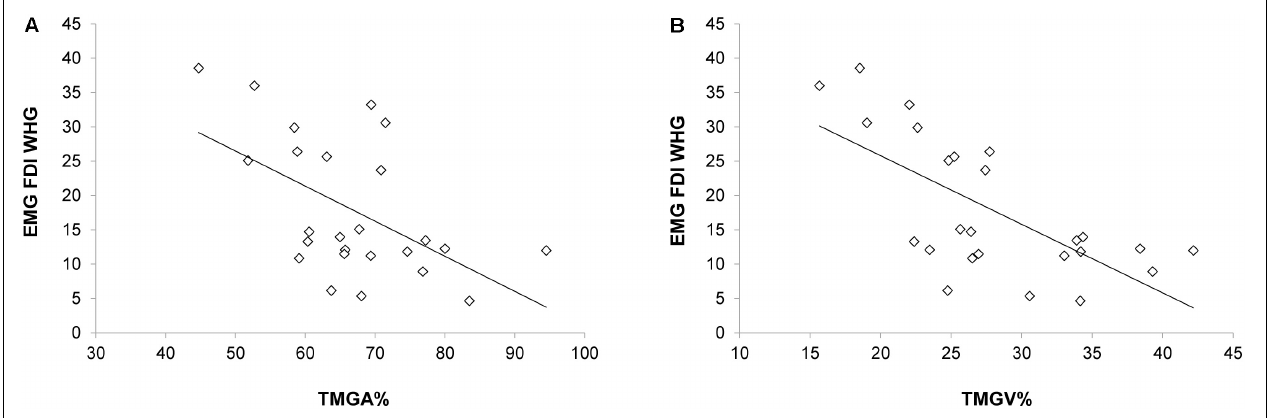
FIGURE 5 | Negative correlations between the EMG activity ( T individualized ) in the FDI muscle during the WHG and (A) the time at which the grip aperture was maximum from movement onset and (B) the time at which the velocity of grip aperture was maximum from movement